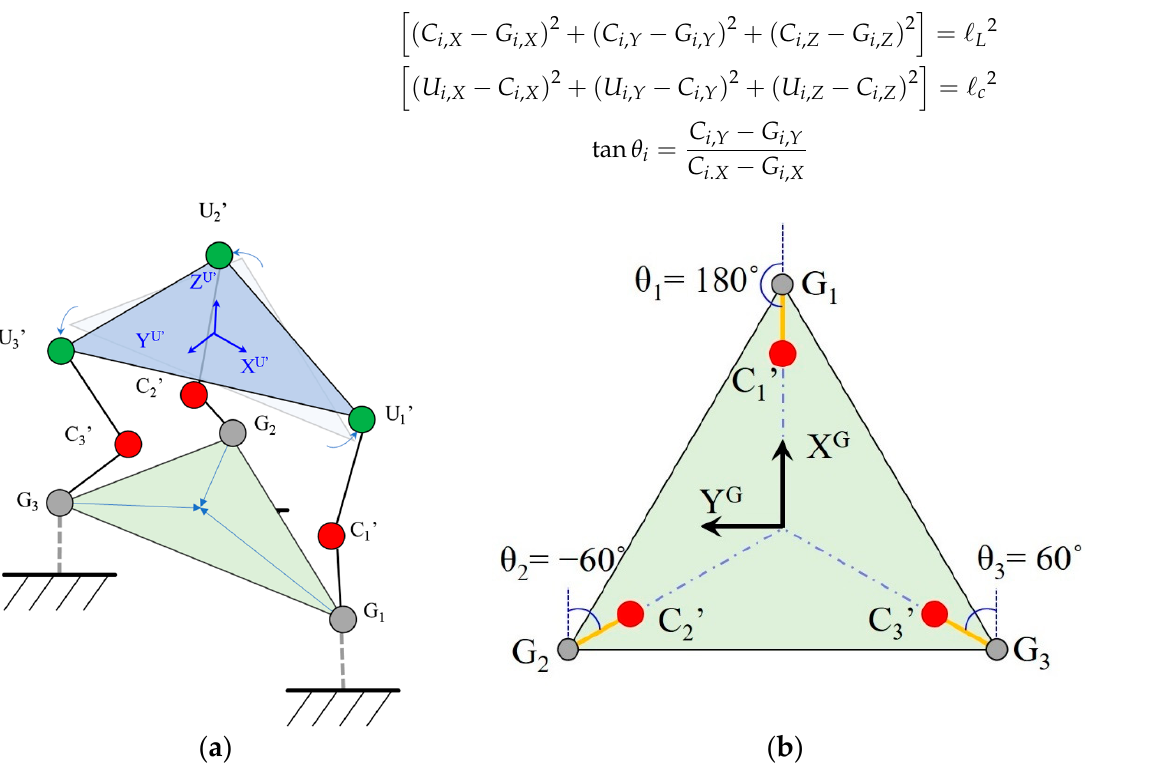
Figure 6. The dimension of the platform.